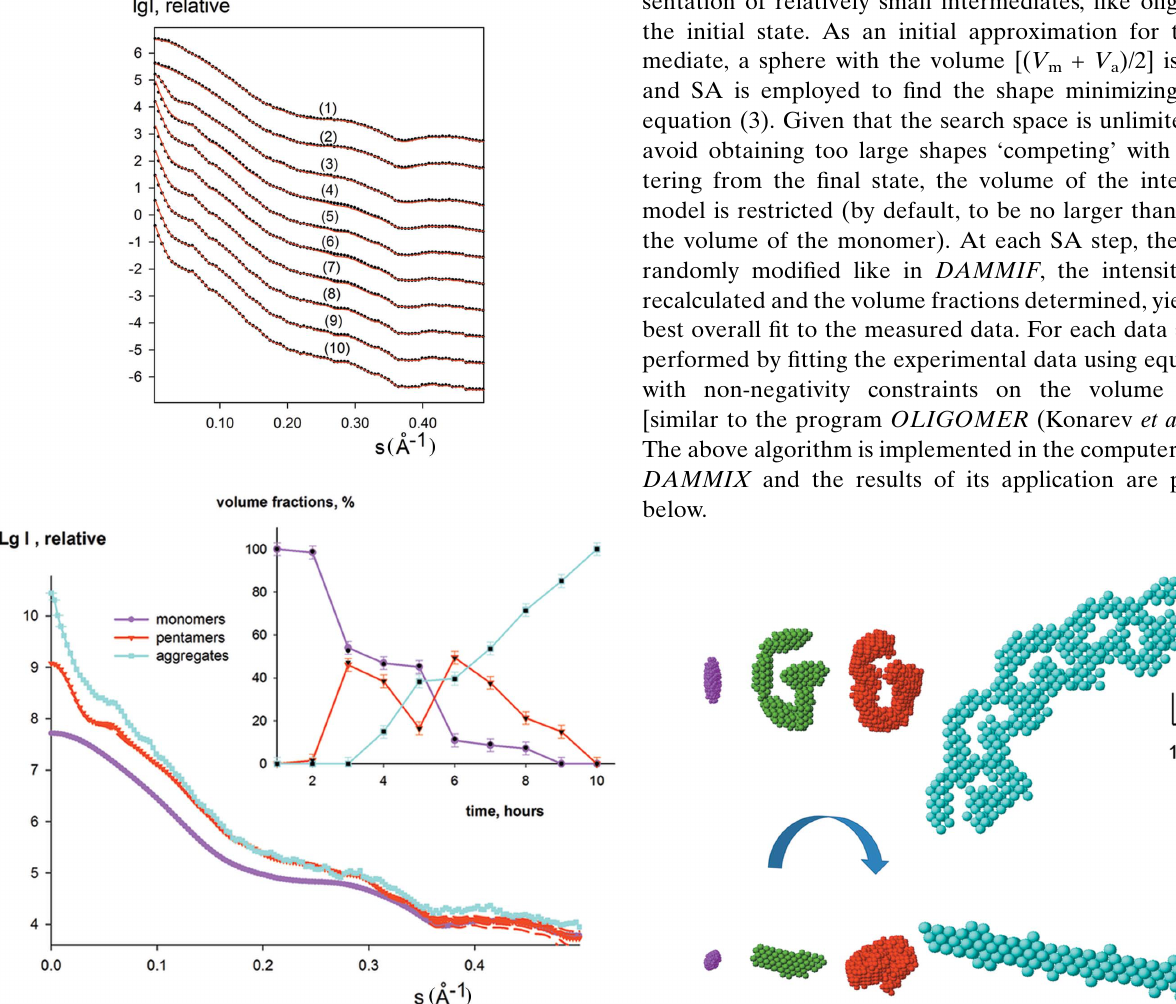
Figure 1 Simulated scattering curves from an evolving system (initial state, an ellipsoid; intermediate state, G-like structure from five ellipsoids; and final state, aggregate composed from five G-like intermediates). The pure species curves from the bead models were calculated using DAMMIN , the linear combinations with the ‘designed’ volume fractions were generated using PRIMUS (Konarev et al. , 2003). A relative error of 2% was added to the simulated data. In the top left panel, the simulated data are shown as dots, the fits as red solid lines. The shapes of the components (ellipsoid, G-structure, aggregate) are shown in the bottom right panel with magenta, green and cyan beads, respectively. A typical restored shape of the intermediate by DAMMIX is displayed in the bottom right panel with red beads. The scale bar is 100 A˚ . The scattering curves from the components are shown in the bottom left panel (the two most different restored curves for the intermediate obtained from multiple DAMMIX runs are shown with dashed red lines) and their restored volume fractions are displayed as an inset (the colours are the same as for the bottom right panel) together with the actual volume fractions used in the modelling (black; the error bars of volume fractions display the average dispersion over multiple DAMMIX